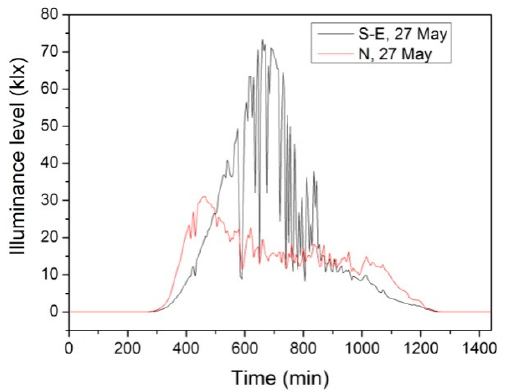
Figure 5. Illuminance levels of daylight measured at the same time by the sensors located on the south-east (S-E) and north (N) side of the building.